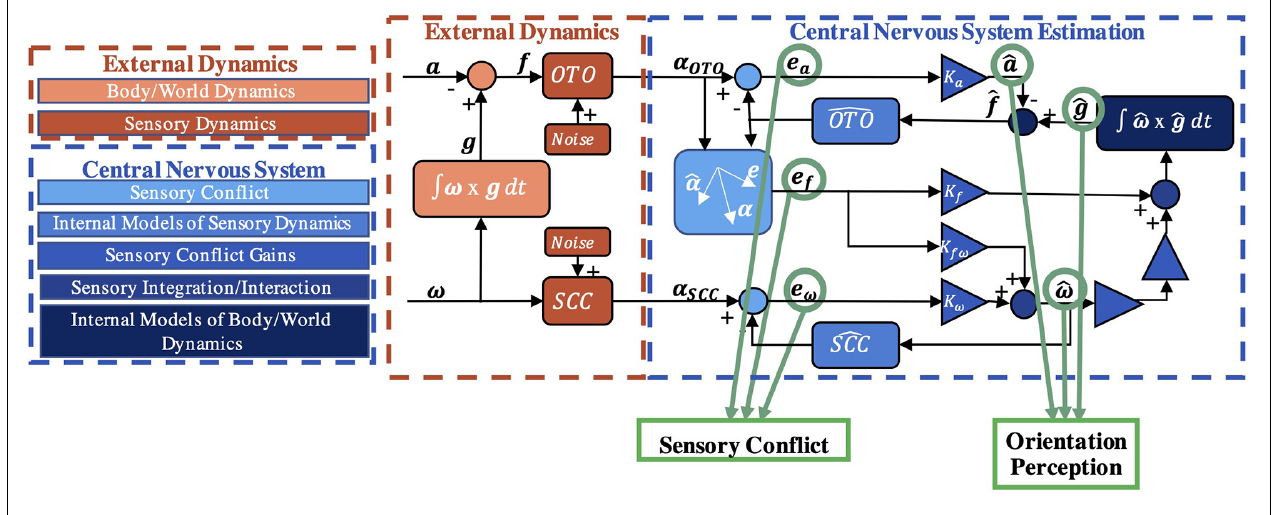
FIGURE 1 | Vestibular portion of the observer model. The model input is a time history of physical self-motion (linear acceleration a , angular velocity ω , gravity g ) and predicts dynamic spatial orientation perception ( ˆ a , ˆ ω , ˆ g , where the “hat” indicates a perception) driven by sensory conflict cues ( e a , e f , e ω ) resulting from comparisons of incoming afferent signals ( α OTO , α SCC ) to the expectation (Merfeld et al., 1993a; Clark et al., 2019). Bold denotes a 3D vector.